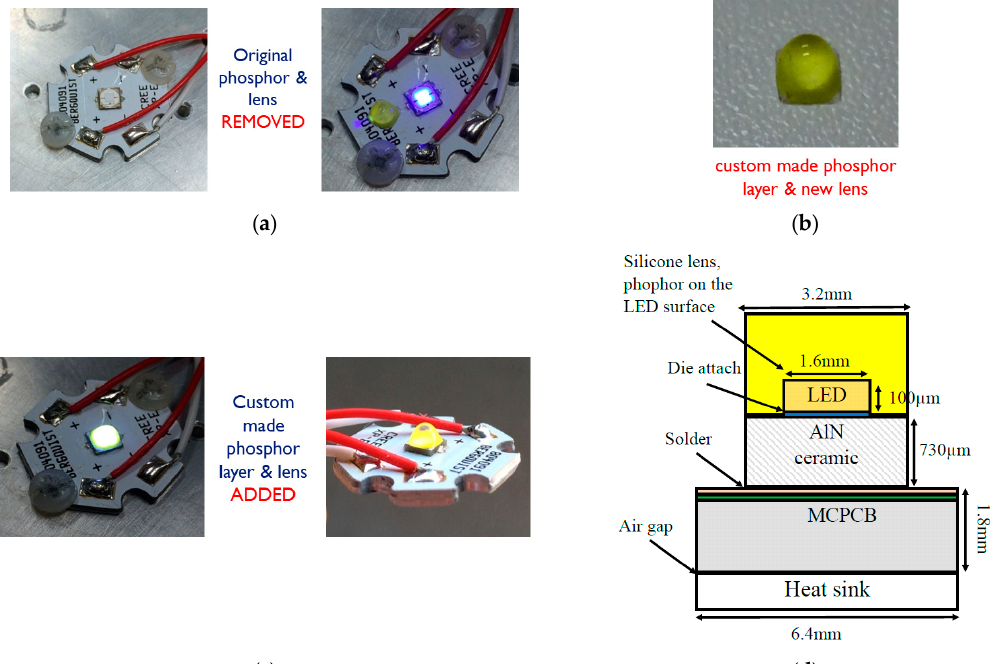
Figure 11. Creating our own white LEDs from Cree XPG3 LEDs: ( a ) Bare blue LED packages with original phosphor and lens removed, ( b ) custom-made phosphor layer with known composition and new lens, ( c ) blue LED packages with the new phosphor + lens structure attached, ( d ) simplified cross-sectional view of the custom-made LED structures used for simulations [24] to validate the simulator. For the explanation of abbreviations used in this figure see the Appendix.